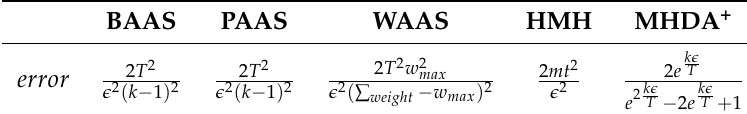
Table 5. Comparison of the